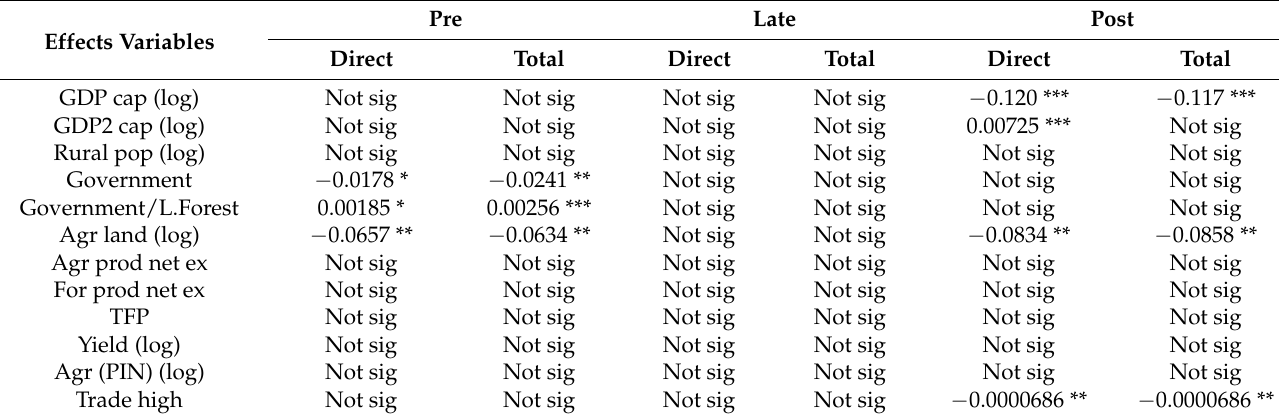
Table 11. Assessment of indirect effects, forest transition